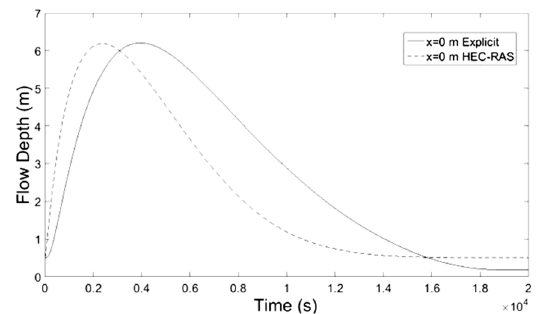
Figure 2. Flow Depth-Time at x = 0 m.